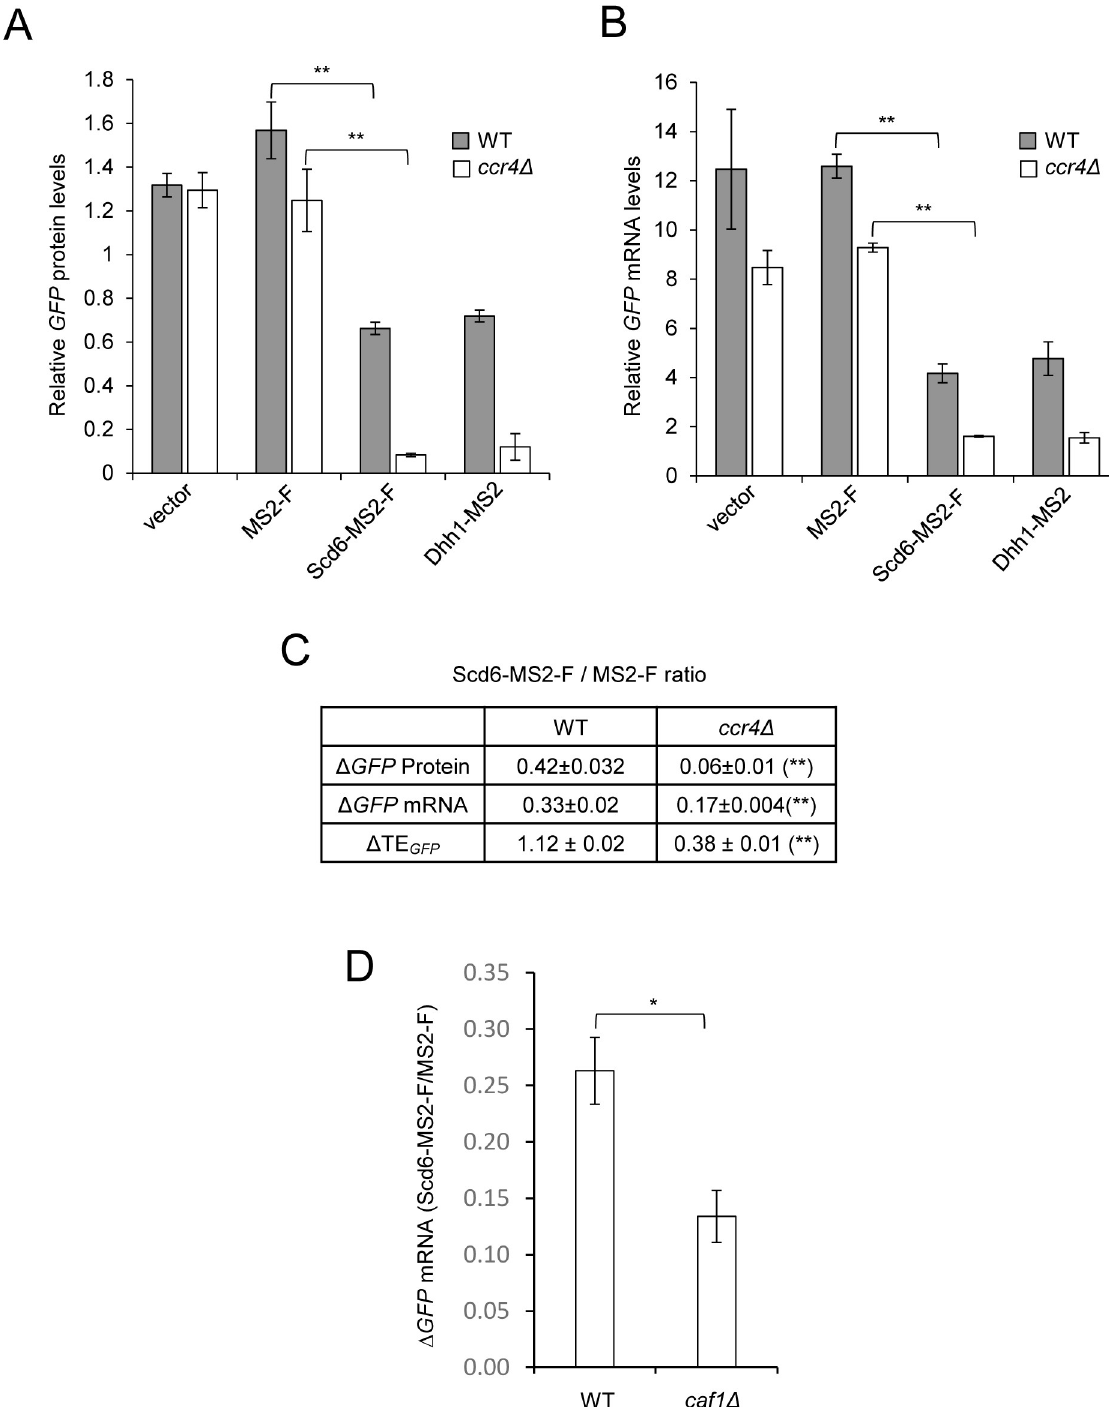
Fig 4. Evidence that both translational repression and mRNA turnover evoked by tethered Scd6-MS2-F are intensified in ccr4 Δ cells. (A-D) Transformants of isogenic WT (BY4741) and ccr4 Δ (387) strains (A-C), or WT (BY4741) and caf1 Δ (7123) strains (D), harboring the GFP reporter and MS2 fusion expression plasmids described in Fig 1 were analyzed for reporter protein (A) and mRNA (B,D) expression as in Fig 1B–1D. Mean values ( ± S.E.M.s) were determined from at least three biological replicates. Calculations of S.E.M.s for changes in mean ratios of GFP protein and mRNA expression shown in (C & D), and determination of P-values from significance testing of differences in mean values in (A-D) using an unpaired Student’s t-test, were conducted as described in the supporting file S1 Text. P-values are summarized as: �� , P < 0.01; � , P < 0.05. P-values for panel A are < 0.0001 (WT) and 0.0012 ( ccr4 Δ ); P-values for panel B are < 0.0001 for both WT and ccr4 Δ